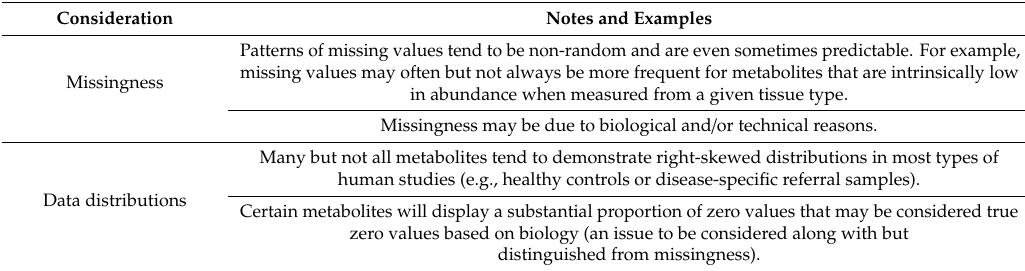
Table 1. Statistical considerations for human metabolomics